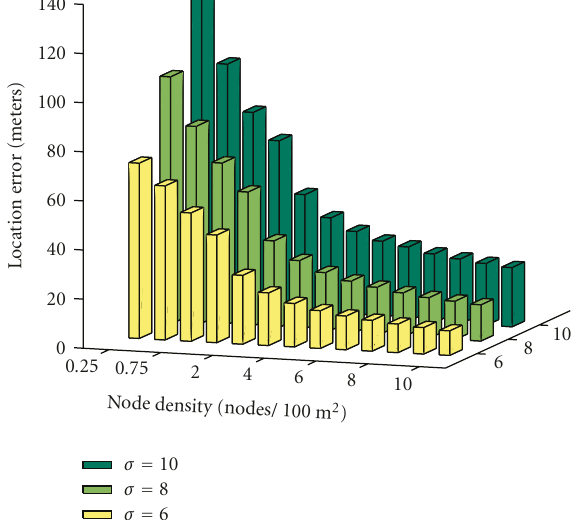
Figure 7: REWL ( λ = 0.15) location error by signal shadowing for 2.4GHz.